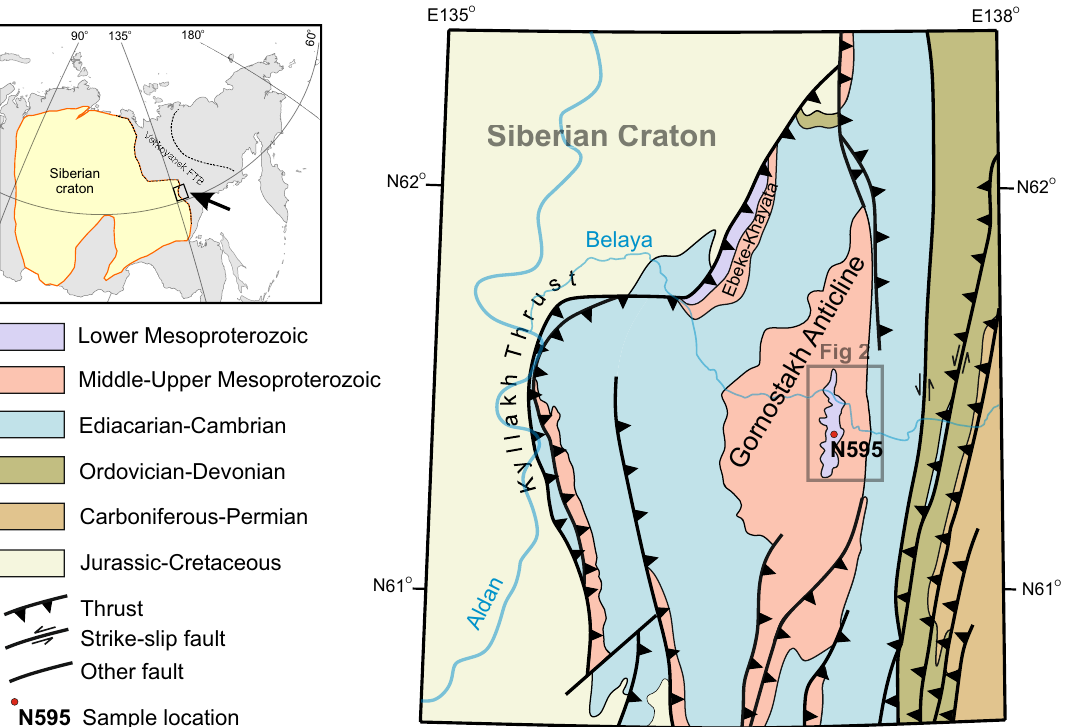
Figure 1. Simplified geological and sample location map of the central part of Sette-Daban Range and surrounding areas (after 20,25 , simplified and